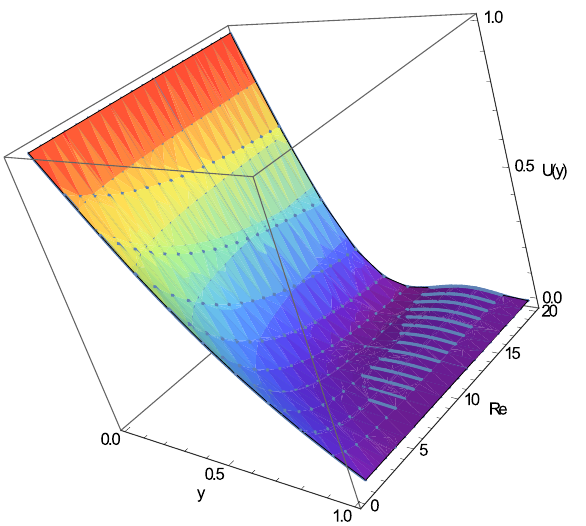
Figure 3. The effect of the increase of Re on U for the case Ha = 0—three dimensional plot.